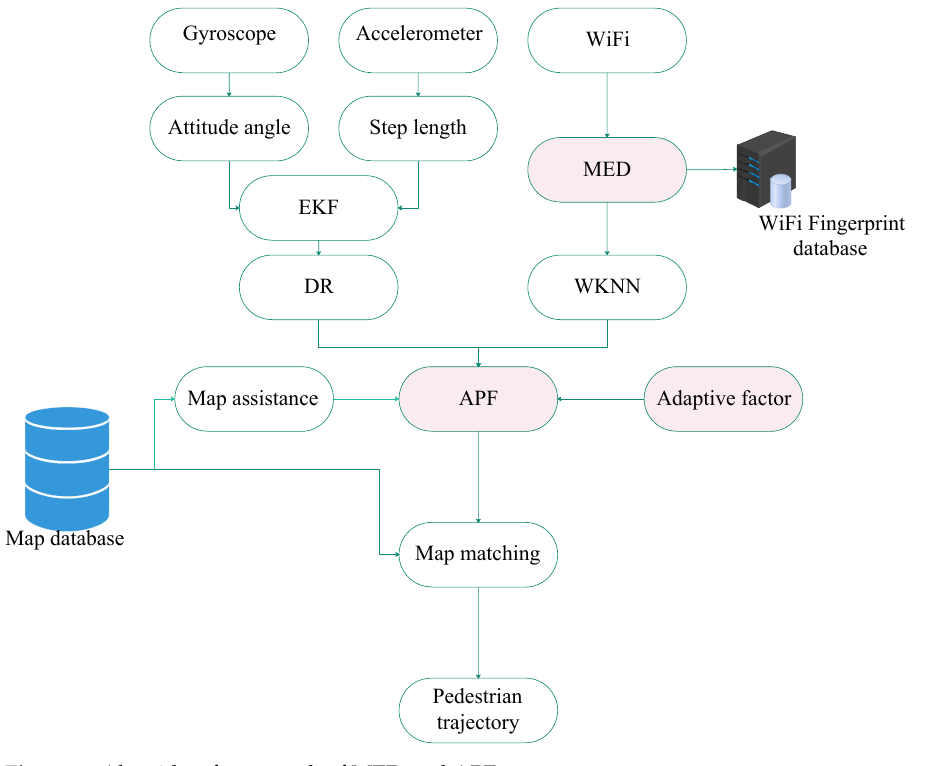
Figure 1. Algorithm framework of MED and